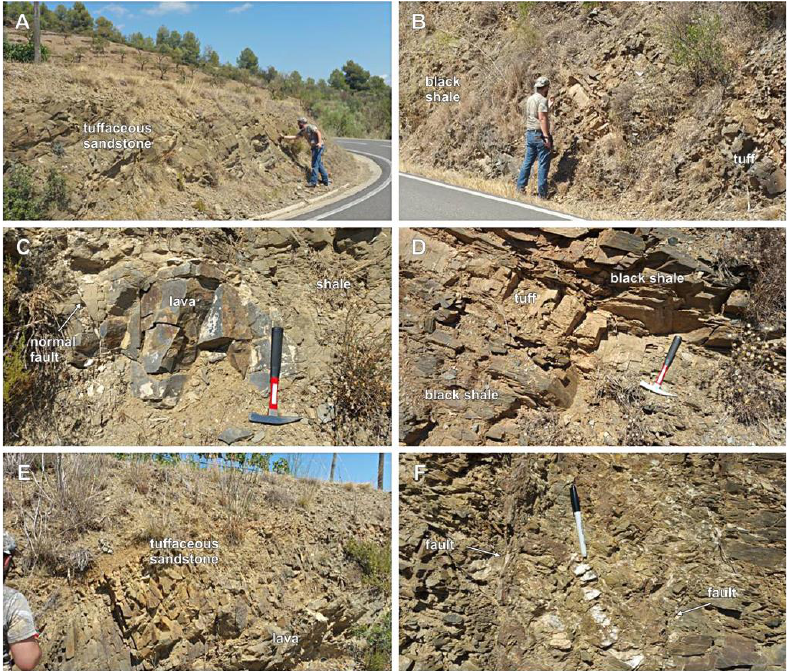
Figure 2. Field relations in the Paleozoic basement of the Priorat DOQ region (CCR). ( A ) Part of the limb of a recumbent fault. Note Grenache vines on the left top of the outcrop. ( B ) Part of a small (~30 m) anticline fold. ( C ) Typical character of lava outcrop in the Priorat DOQ area overlain by black shale. ( D ) Interbedding of black shale and lithocrystalloclastic tuff. ( E ) Part of the limb of an overturned fold. ( F ) General nature of normal faulting in the Paleozoic basement emphasized by distribution of milky quartz selvages.